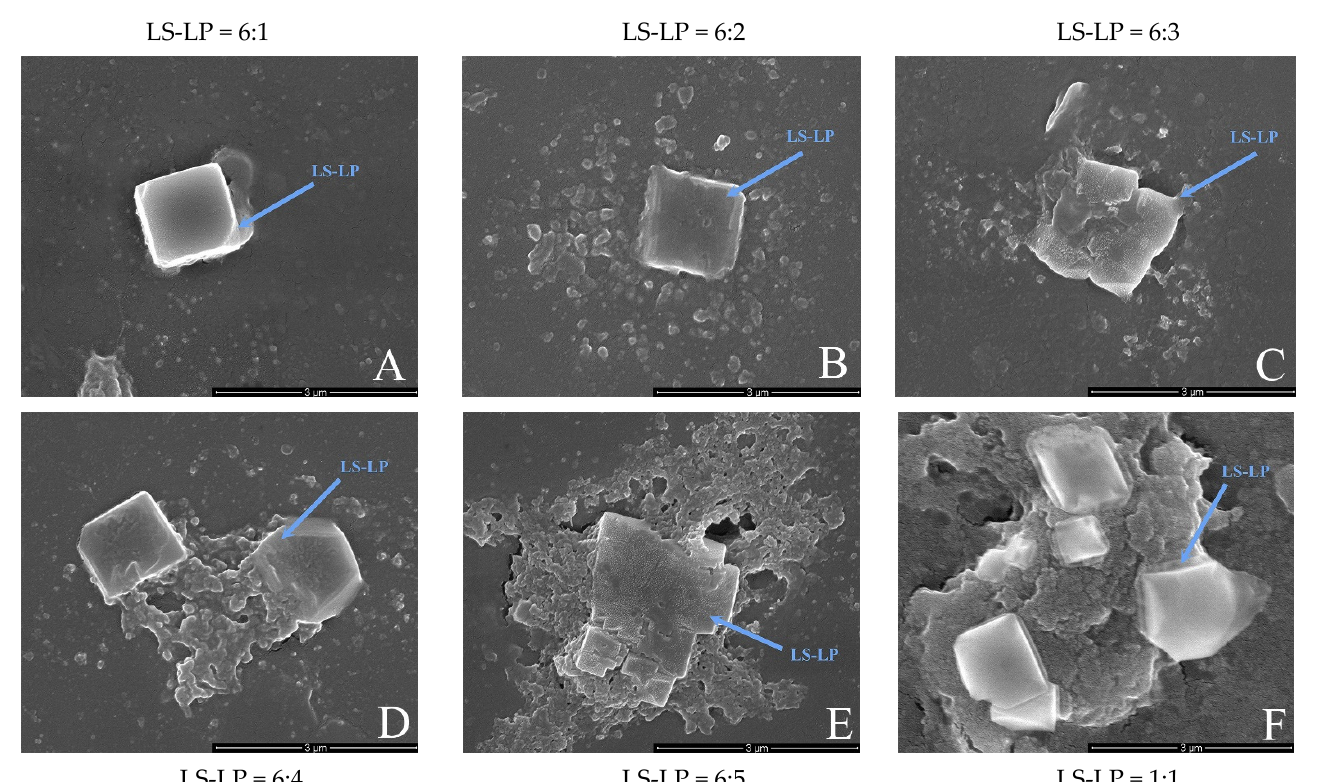
Figure 4. The scanning electron microscopy (SEM) image of lotus seed starch–protein mixture ( × 50,000). Note: Picture ( A − F ) indicates the different ratio of lotus seed starch–protein (LS-LP = 6:1–5 or 1:1).